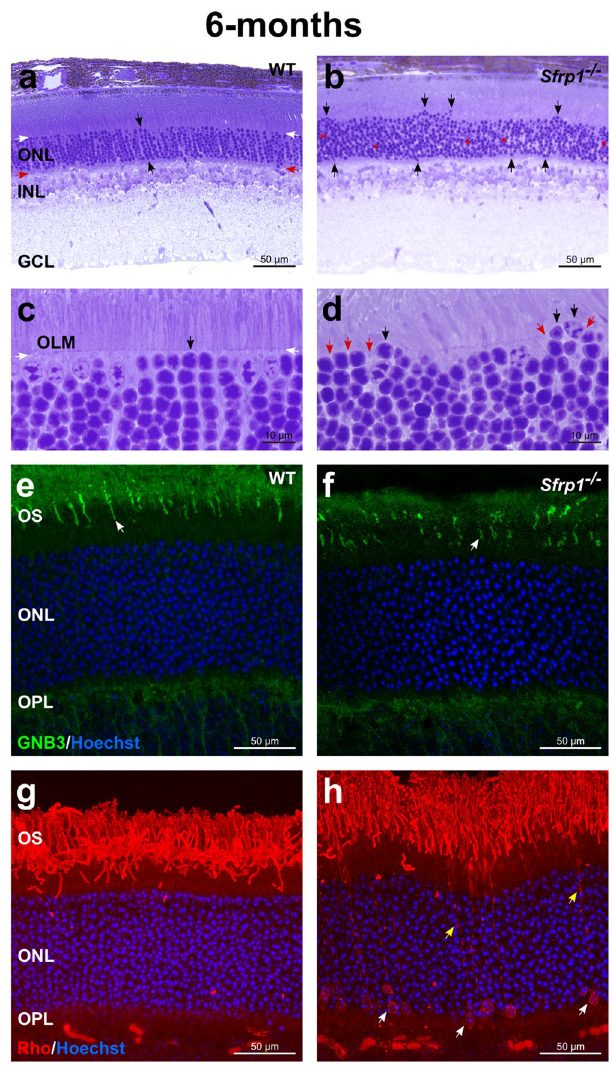
Figure 3. Morphological alterations of Sfrp1 − / − retinas become more evident with age. ( a – d ) Semi-thin plastic frontal sections from 6 months-old wt and Sfrp1 − / − retinas stained with toluidine blue. Black arrows in a,c indicate an organized column of photoreceptors, whereas white and red arrows indicate the outer and inner limit of the ONL. In b and d black and red arrows point to misplaced photoreceptor nuclei and discontinuous OLM respectively. ( e–h) Frontal cryostat sections from 6 months-old wt and Sfrp1 − / − retinas immunostained with anti GNB3 (cones) or Rho (rods) antibodies and counterstained with Hoechst. White arrows in e,f point to the OS. Yellow and white arrows in h indicate accumulation of Rho in rod processes and cell bodies